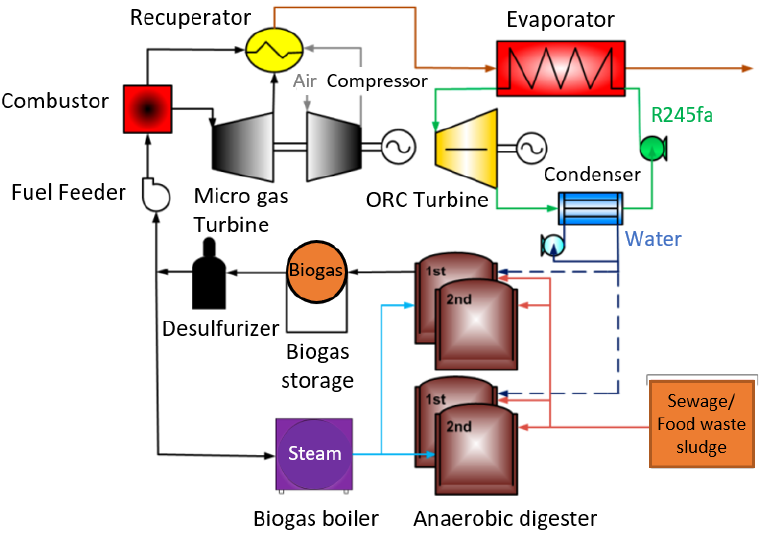
Figure 18. Schematic diagram of a biogas-fuelled MGT with bottoming ORC [124]. The work analyzed thermodynamic performance depending on the system size and the methane concentration in the biogas. The optimal configuration presented a 1000 kW MGT and 150 kW ORC with an anaerobic digester total capacity of 28,000 m 3 . However, when operated in CHP configuration, the net power of the ORC dropped to 128.9 kW because of the reduced expansion ratio. Finally, CH 4 concentration of the product gas varied between 55 and